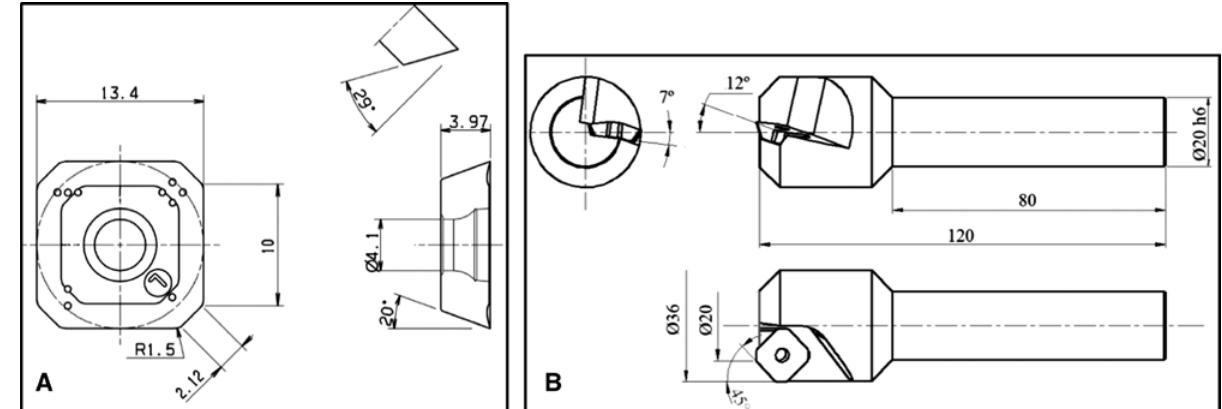
Figure 1: (A) Cutting tool and (B) tool holder dimensions.